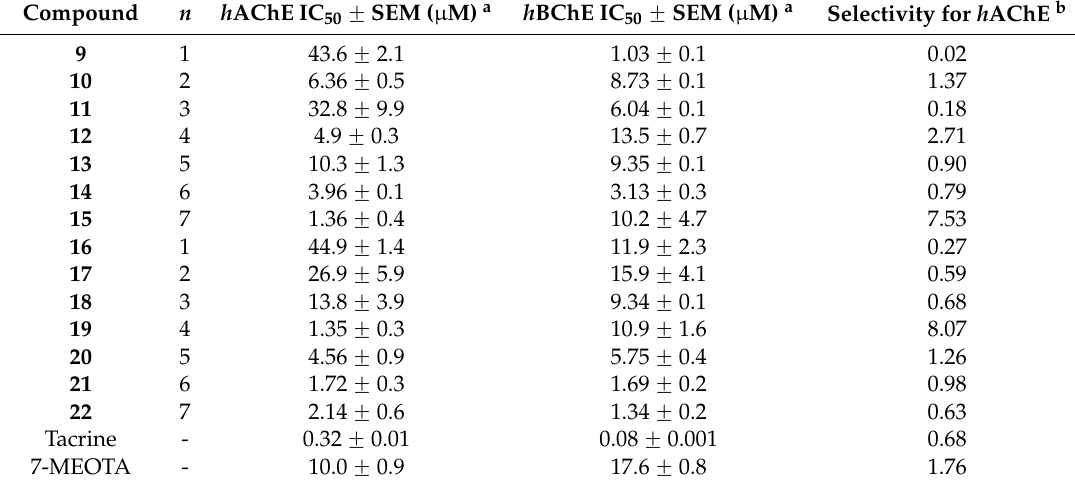
Table 1. Inhibitory activities of newly developed 7-MEOTA- p -anisidine hybrids 9 – 22 and reference compounds (tacrine and 7-MEOTA) for h AChE and h BChE expressed as IC 50 values. Compound n h AChE IC 50 ˘ SEM ( µ M) a h BChE IC 50 ˘ SEM ( µ M) a Selectivity for h AChE